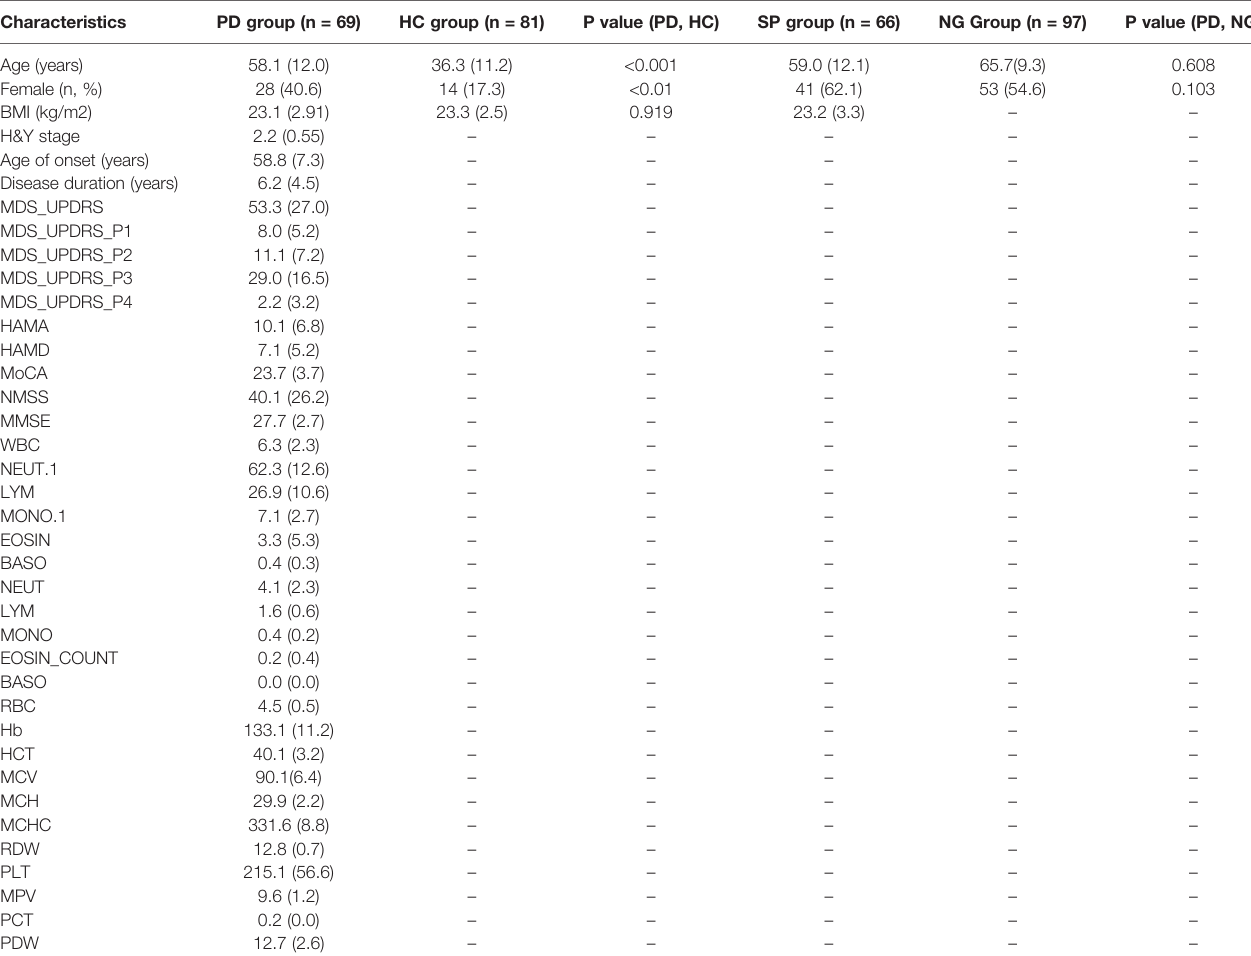
TABLE 1 | Characteristics of the study